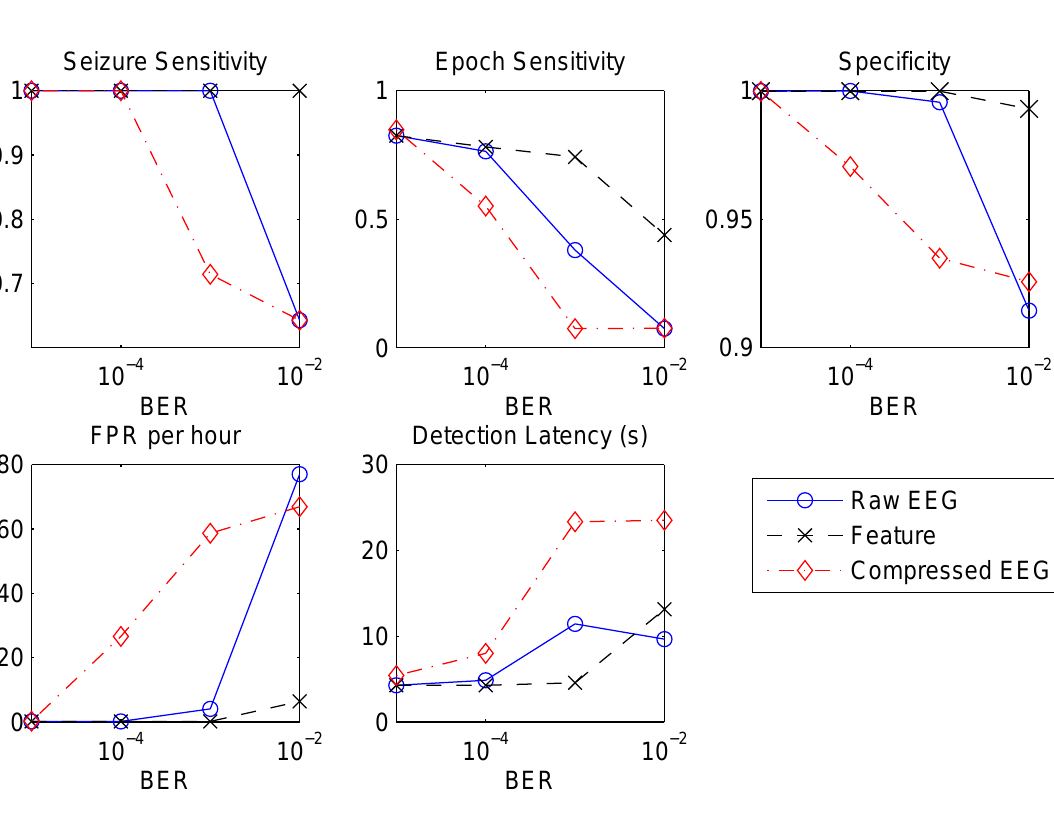
Figure 3. Detection performance as a function of the bit error rate